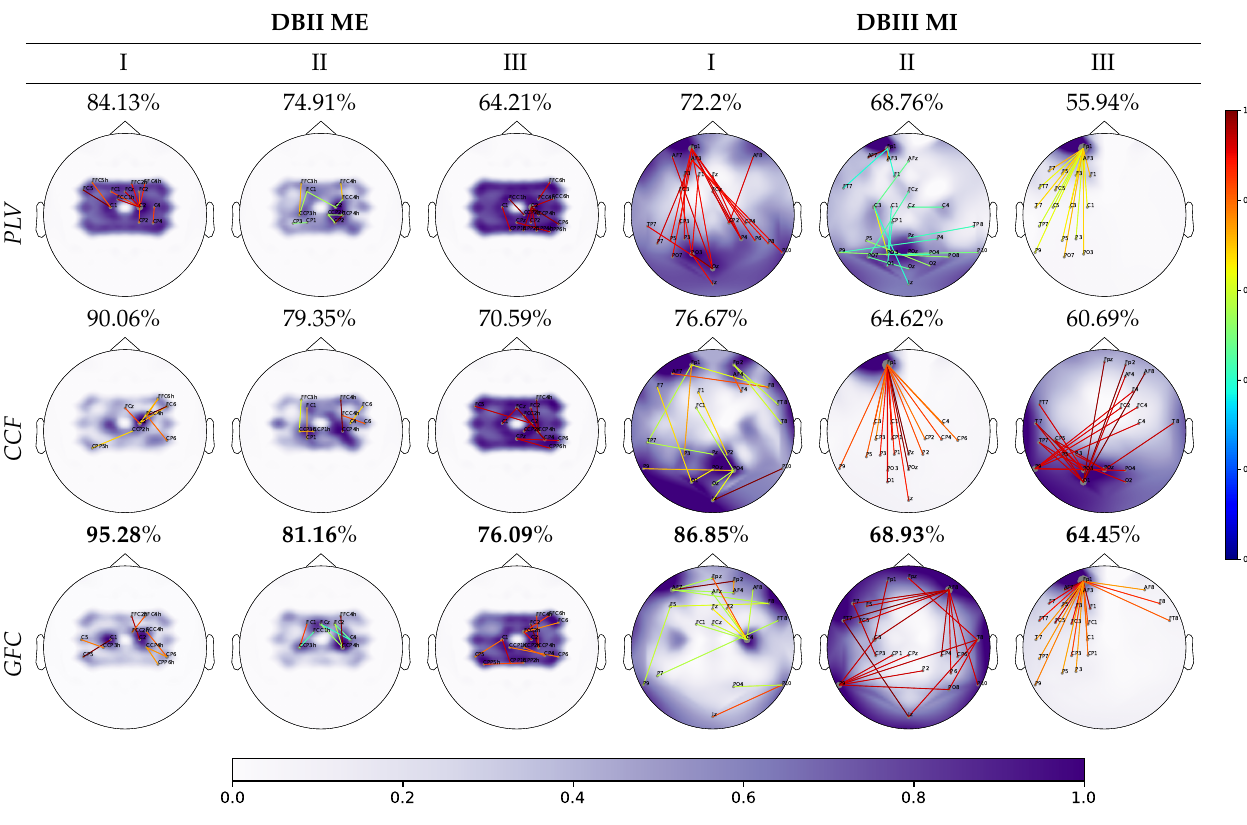
Figure 5. Spatial relevance mapped to topoplots estimated for each group of individuals from the FC measures (regarding the relevance weights v and the classification accuracy). The normalized relevance weights values (between 0 to 1) are computed from Equation (6). The background stands for the accumulated spatial relevance mapped to the EEG channel positions. The colored links represent the normalized FC relevance weights that hold a value higher than the 99 percentile of vector v . Above each plot, the average accuracy is shown over the corresponding